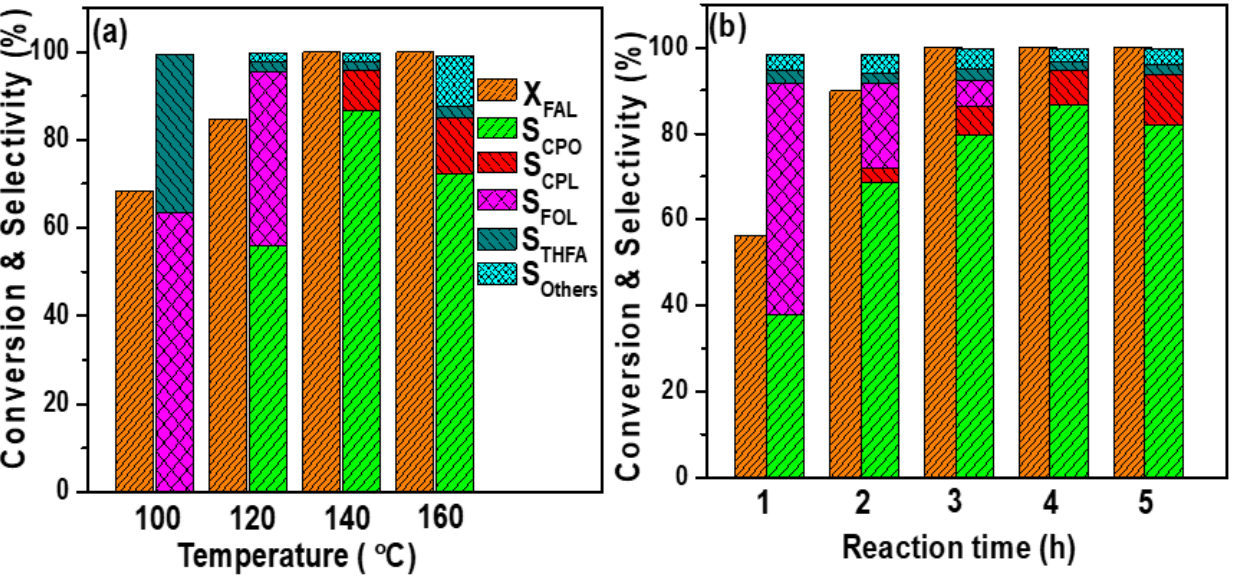
Figure 8. Conversion and selectivity ( a ) at different temperatures for 4 h, and ( b ) with reaction time at 140 °C. Reaction conditions: 0.17 g of Ni 5 Cu 15 /m-SiO 2 , 5.2 mmol of furfural, 15 mL of water, 3 MPa of H 2 pressure and X- conversion of FAL, S-selectivity of desired products.